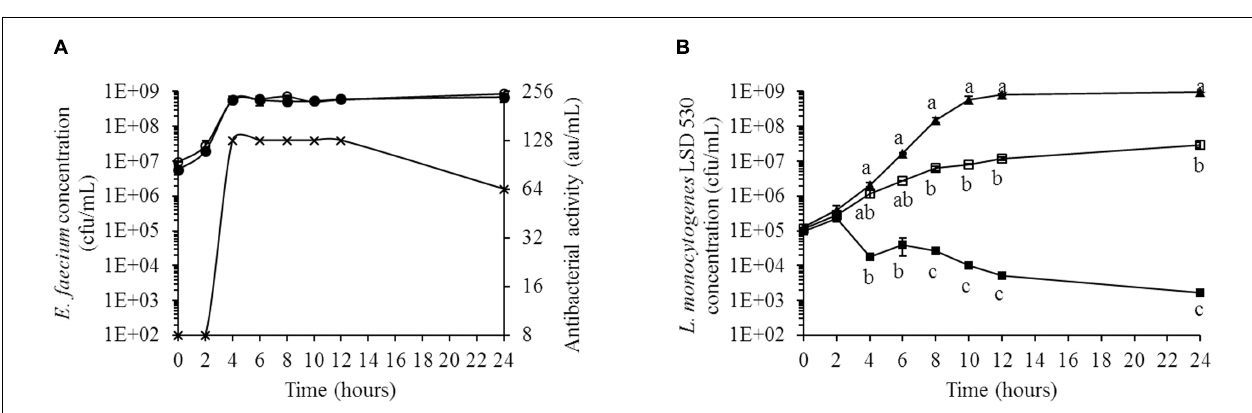
FIGURE 6 | Growth kinetics of L. monocytogenes LSD 530 and E. faecium LCW 44 or its non-bacteriocin-producing mutant LCW 44d in Macfarlane medium (simulated intestinal nutrient content). (A) Counts of E. faecium LCW 44 (black circle) and E. faecium LCW 44d (white circle) in co-culture with L. monocytogenes LSD 530, and antibacterial activity (microtitration assay with P. acidilactici UL5) of E. faecium LCW 44 (cross); (B) Growth kinetics of L. monocytogenes LSD 530 alone (triangle, black), in co-culture with E. faecium LCW 44 (black square) or LCW 44d (white square). Error bars indicate the standard error of the mean. Different letters indicate significant difference between assays (Tukey’s HSD test, P < 0.05, n =